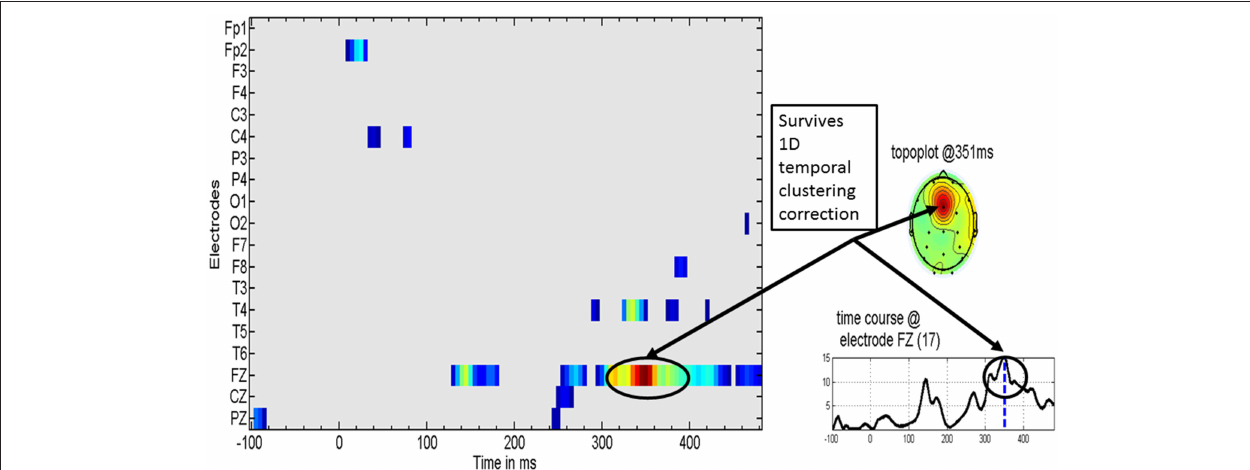
FIGURE 4 | Specific music therapy treatment effect on the mismatch response. (Left) Plot of MT treatment effect for each EEG derivation (y axis) and time (x axis). The t -values are thresholded at the uncorrected univariate for p = 0.01 level. (Right top) Topography of the t statistic at the most significant time point. (Right bottom) the t waveform for the most significant derivation (Fz). Highlighted with circles is the time interval for which the t -tests correction for multiple comparisons was significant. The dashed line for the t waveform indicates the maximum significance at 351ms.